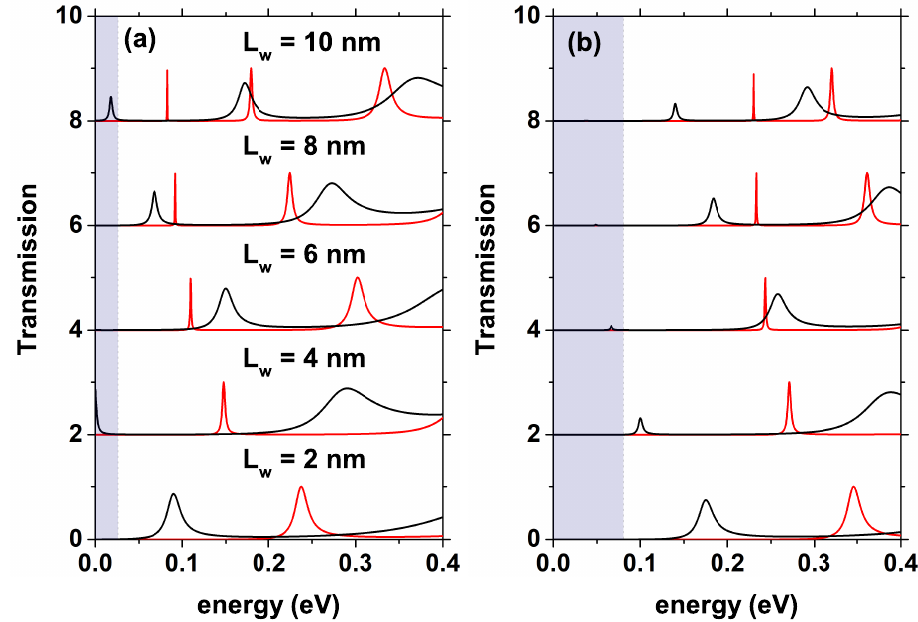
Figure 6. Transmission coefficient for different values of L w , the red curve corresponds to 0.0V, and the black curve corresponds to 0.4V. ( a ) with n d fixed at 1.2 × 10 18 [1/cm 3 ], and ( b ) with n d fixed at 10 × 10 18 [1/cm 3 ]. The shaded area indicates the region between the bottom of the conduction band and the quasi-Fermi level at the